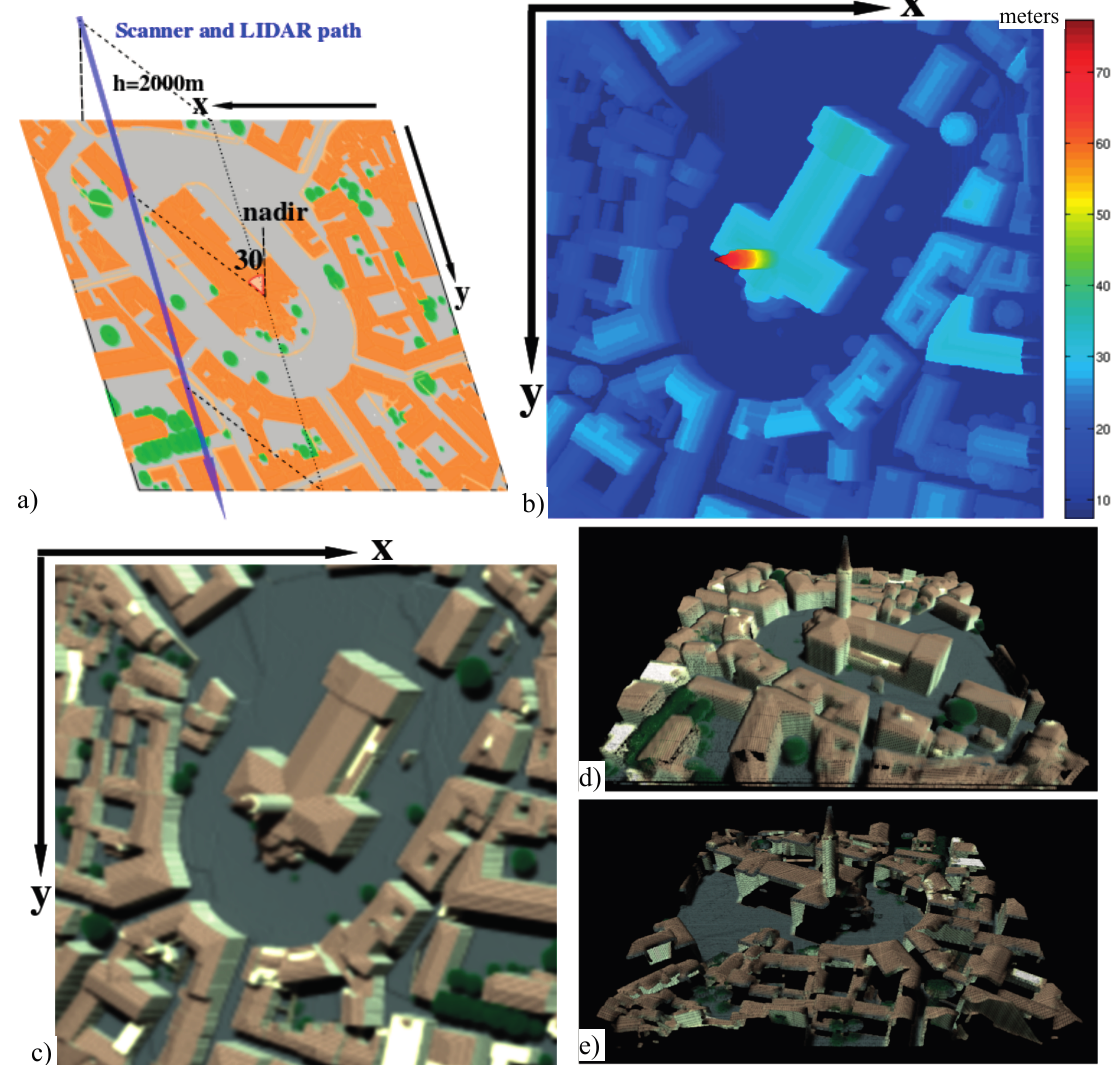
Figure 19. DART fusion of LIDAR and spectral images of St Sernin Basilica (Toulouse, France). ( a ) Acquisition geometry. ( b ) Multi-pulse LIDAR image. ( c ) RGB composition of corresponding spectral image. ( d ) and ( e ) Products of LIDAR-spectral fusion for two opposite viewing